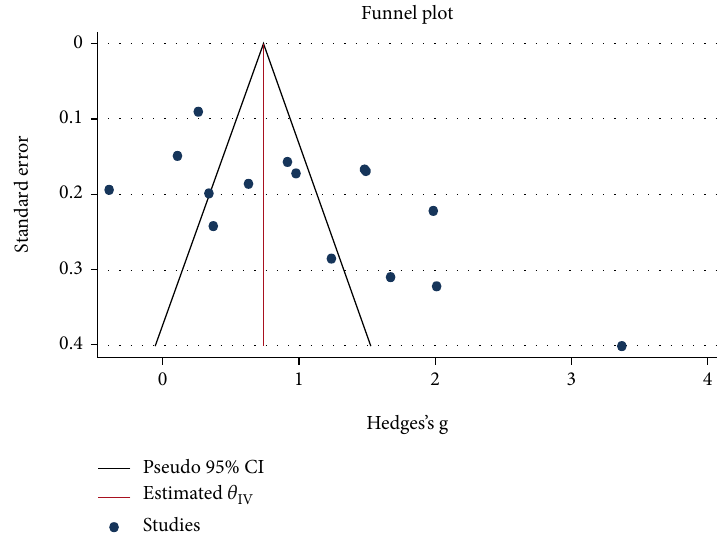
Figure 5: Funnel plot assessing publication